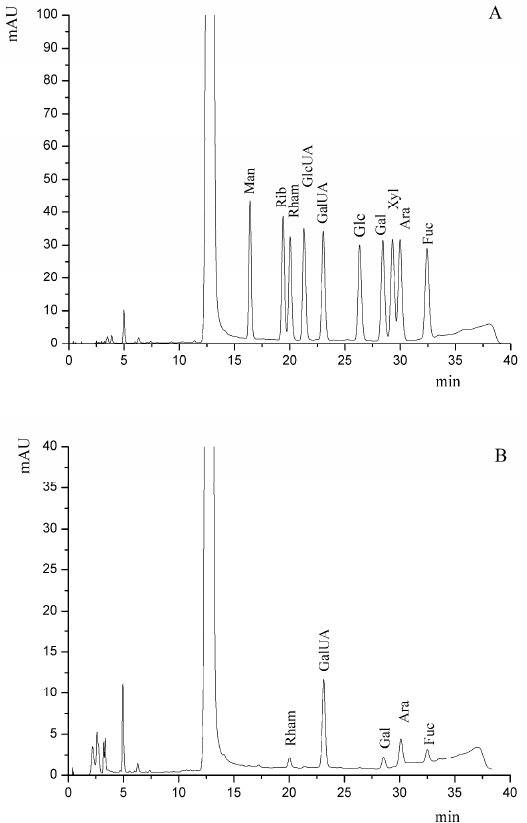
Figure 2. HPLC chromatograms of PMP derivatives of component monosaccharides released from ( A ) sugar standards(Peaks from left to right: Mannose, Ribose, Rhamnose, Glucuronic acid, Galacturonic acid, Glucose, Galactose, Xylose, Arabinose, Fucose with retention time from 15 to 35 min) and ( B ) the purified SJP.